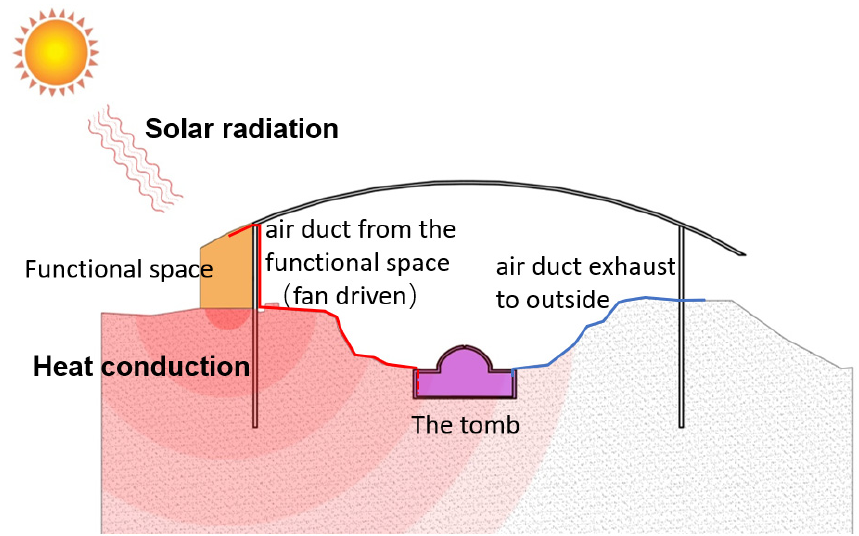
Figure 7. Schematic diagram of the proposed method.